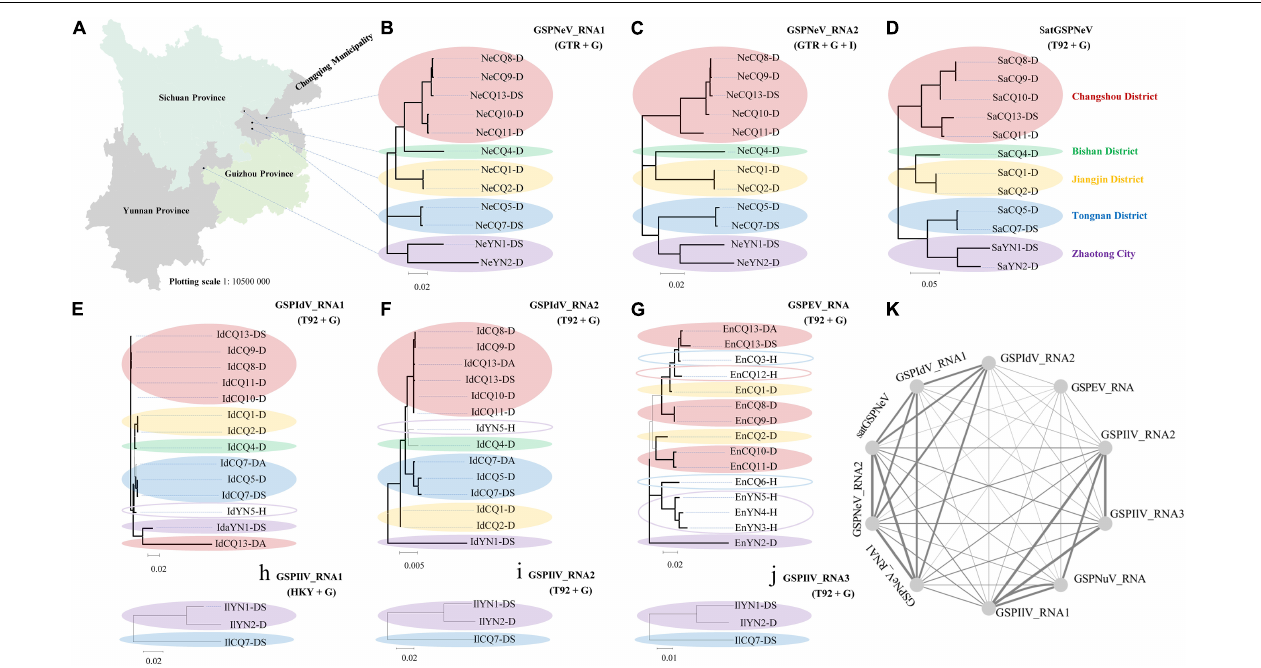
FIGURE 3 | Phylogenetic and geographical analysis of available viral/subviral isolates. A map showing the sampling sites, which are shown with black circles (A) . Co-evolution and co-transmission relationship constructions of green Sichuan pepper-nepovirus—GSPNeV (B,C) , -nepovirus large linear satellite RNA—satGSPNeV (D) , -idaeovirus—GSPIdV (E–G) , -enamovirus—GSPEV (H) , -nucleorhabdovirus—GSPNuV (analysis not available for only one isolate), and -ilarvirus—GSPIlV (H–J) , based on the phylogenetic and geographical differences. The tree structures and geographical distributions of GSPNeV RNAs and satGSPNeV were used as references for comparisons and penalty point calculations. Isolates with the same locations are indicated by solid ellipses with the same color, and hollow ellipses represent isolates with unique distributions, compared with GSPNeV RNAs and satGSPNeV. Network visualization of the relationships by adding up penalties between two RNAs (K) ; each node represents a different RNA. The models recommended by MEGA-X for phylogenetic analyses are indicated. The nodes with significant bootstrap values ( > 50%) are highlighted with thick lines.